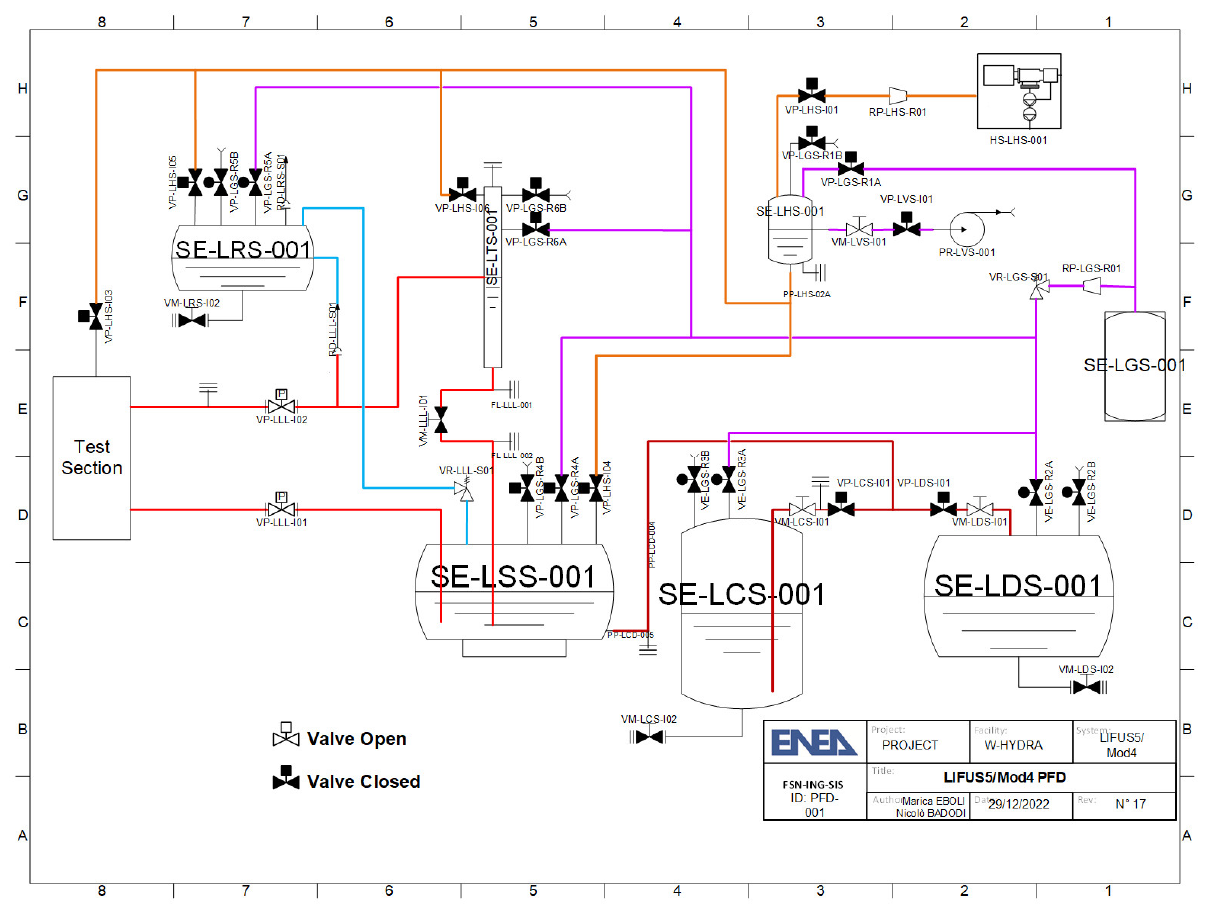
Figure 2. LIFUS5/Mod4 PFD.